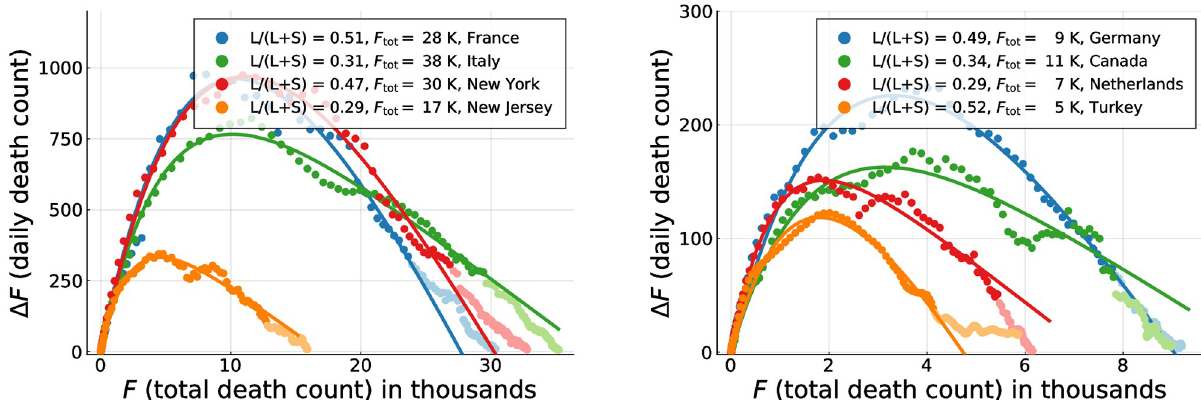
Fig 4. COVID-19 containment policies. Daily fatalities Δ F as a function of total death counts F . Comparison of data (seven-day centred averages, filled circles) and theory (lines). Points with lighter hue correspond to dates d > d 0 not part of the parameter estimation. The theory corresponds to optimal fits of the exact solution (16) of the controlled SIR model, Eqs (1) and (2). The relative importance of long-term control, L /( L + S ), as defined by Eq (8), is given, together with the model based estimate of the total death toll, F tot (assuming a single COVID-19 peak/outbreak). Containment policy parameters for all countries and the degree of agreement between theory and data are presented in Table